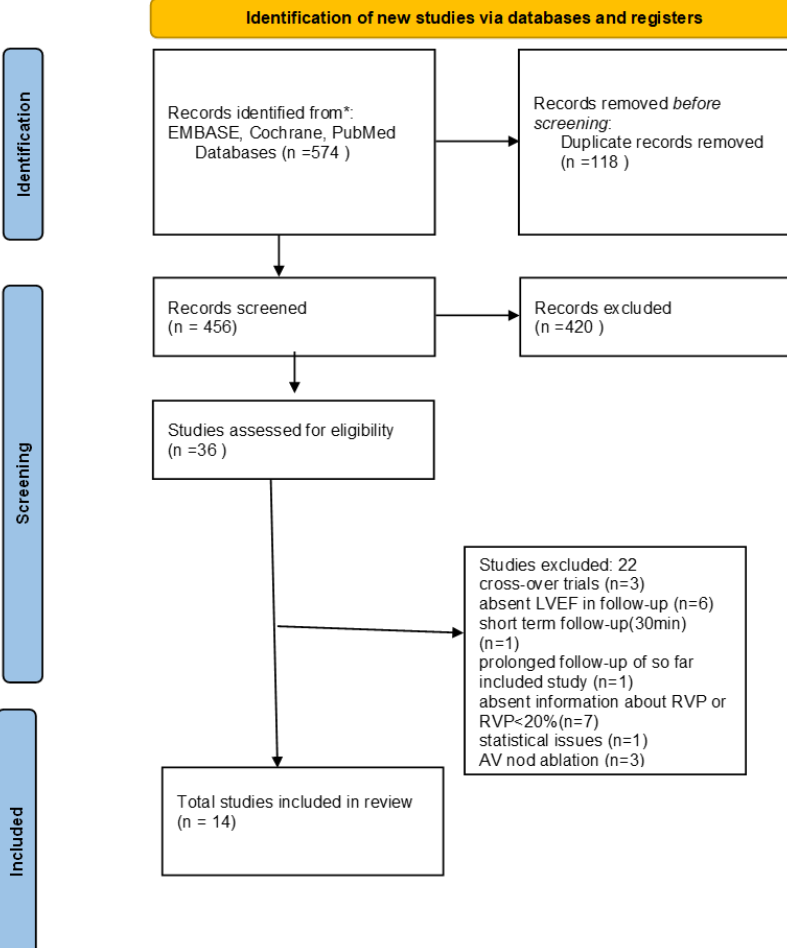
Figure 1. PRISMA flow